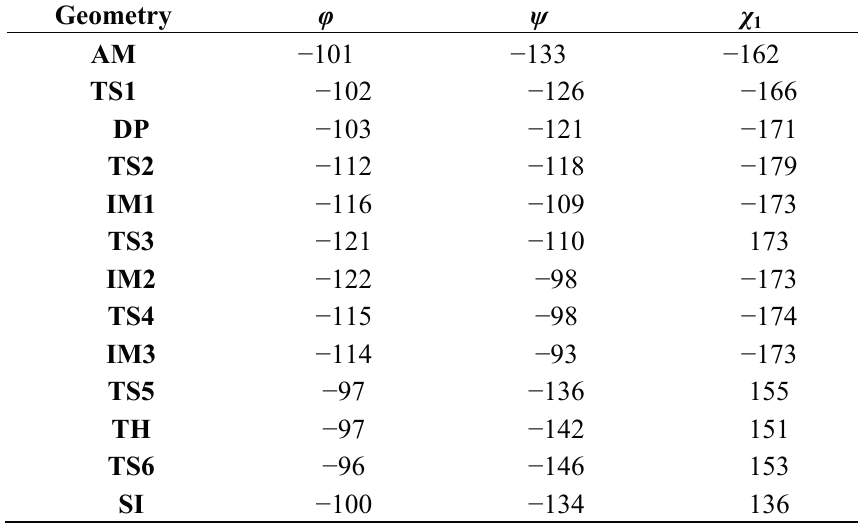
Table 1. The φ , ψ , and χ dihedral angles (°) (Figure 13) of the optimized 1